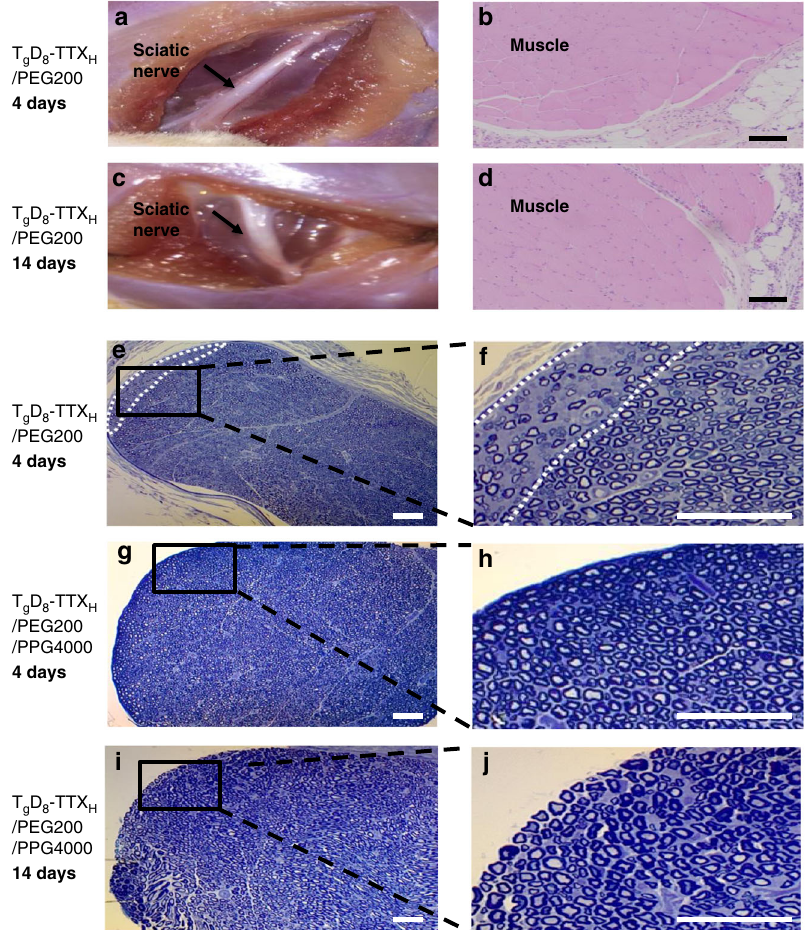
Fig. 7 Tissue reaction to materials. a , c Representative photographs of the site of injection upon dissection 4 and 14 days after injection of 25 mg of T g D 8 – TTX H in 0.5 mL of PEG200. b , d Representative hematoxylin – eosin stained sections of muscles and adjacent loose connective tissue 4 and 14 days after injection of 25 mg of T g D 8 – TTX H in 0.5 mL of PEG200. Scale bars, 100 µ m. e – j Toluidine blue stained sections of nerve after injection of